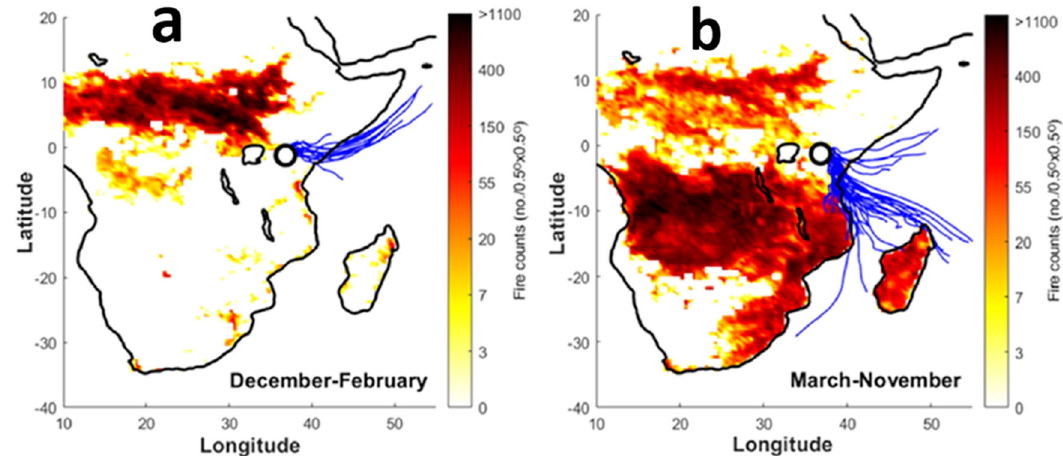
Fig. 1 Fire regimes and airmass back trajectories (BTs, blue lines) during the sampling campaign in Nairobi (white circle with a black outline). a During the December-February period, BTs arriving at Nairobi are mainly from the northeast sector. Meanwhile, large-scale fi res mainly occur downwind, with little expected in fl uence on PM 2.5 composition in Nairobi. b . During March-November, the fi re regime has largely shifted to the south. During this period, BTs arriving at Nairobi partially overlap with the fi res, suggesting a potential impact on the air quality. The fi re data were derived from the NASA Moderate Resolution Imaging Spectroradiometer (MODIS) satellite product for March 2014 to February 2015 sampling period. The 5-days air mass BTs were computed every 6 h, with an arrival height of 100 m above ground level (1890m a.s.l). Table 1 Seasonally averaged PM 2.5 and BC concentrations ( μ g m − 3 ), Δ 14 C BC signatures ( ‰ ) and fraction fossil contribution ( ƒ fossil ), shown with mean and standard deviation, for the year-round campaign in